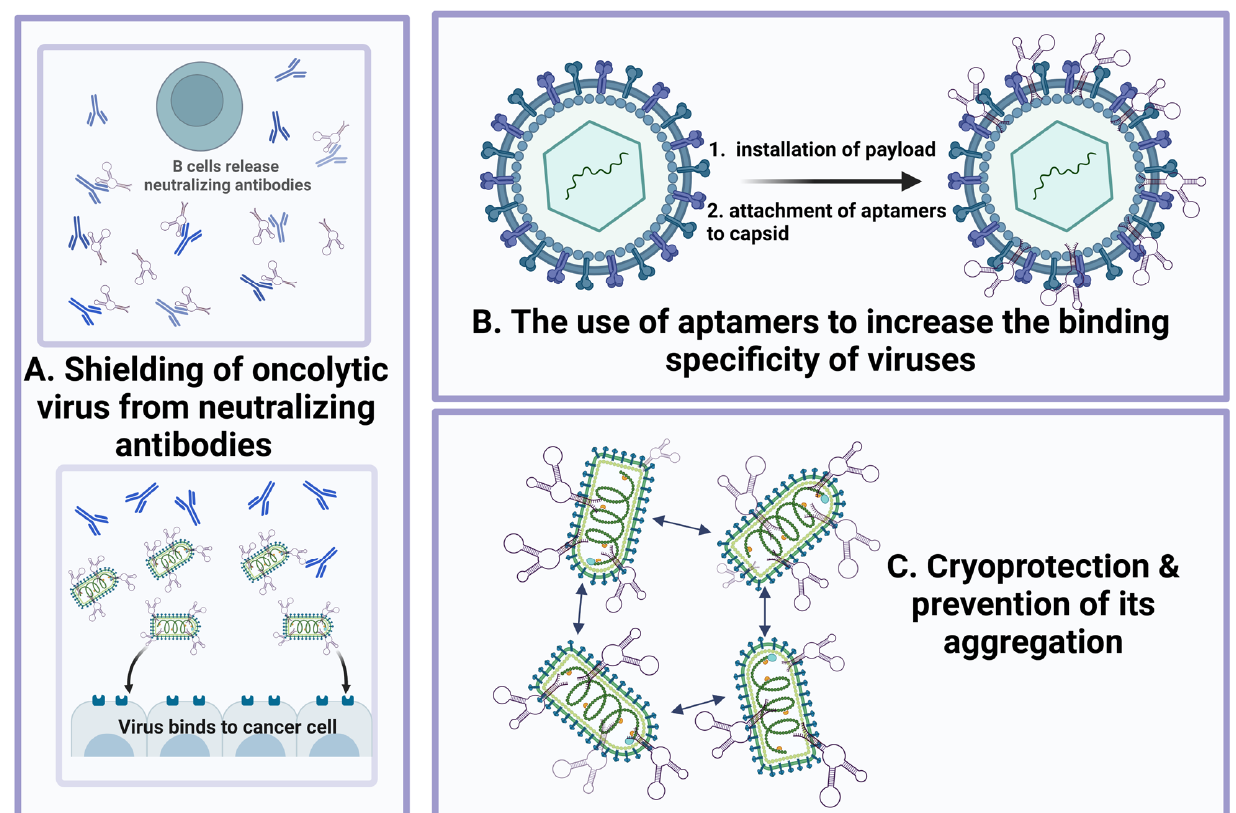
Figure 3. Aptamers increase the antitumor efficacy of oncolytic viruses through different mechanisms: ( A ) shielding oncolytic virus from the neutralizing antibodies (at the same time, aptamers can be specific both to Fab fragments of neutralizing antibodies and to enveloped proteins of the virus); ( B ) use of aptamers to increase the specificity of virus binding; ( C ) cryoprotection and prevention of virus aggregation.